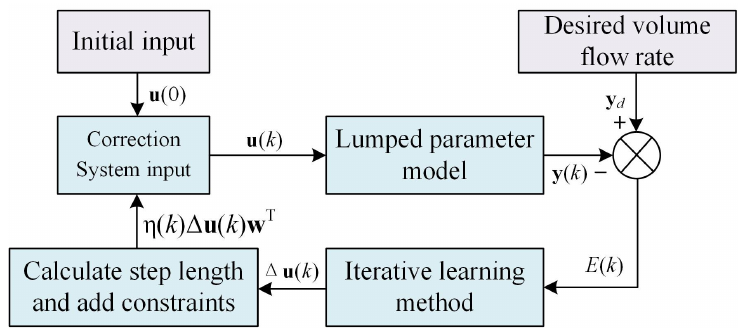
Figure 4. Principles of the iterative learning method.